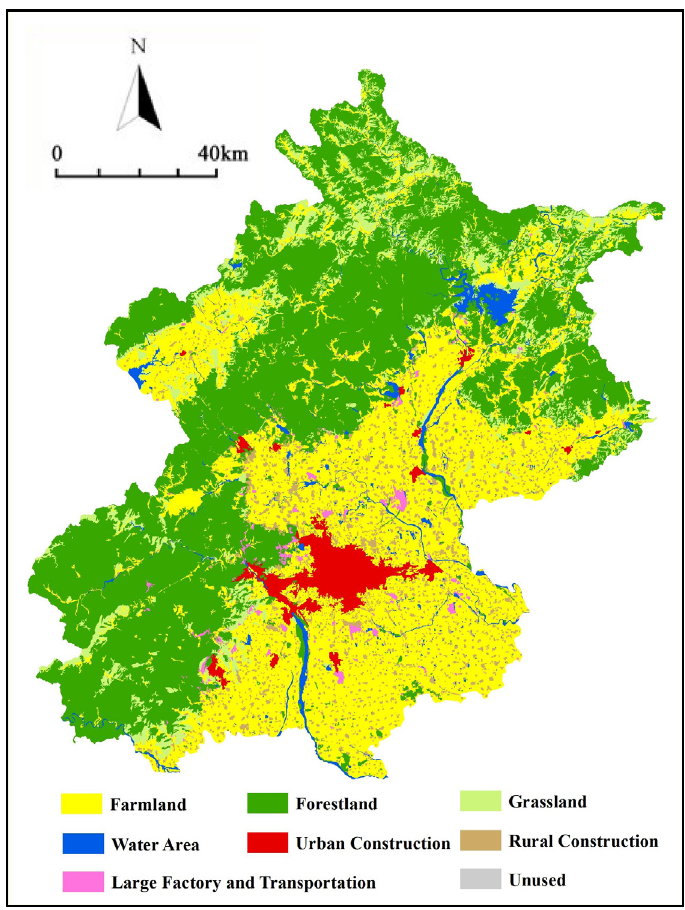
Figure 3. Beijing Land Use Map in